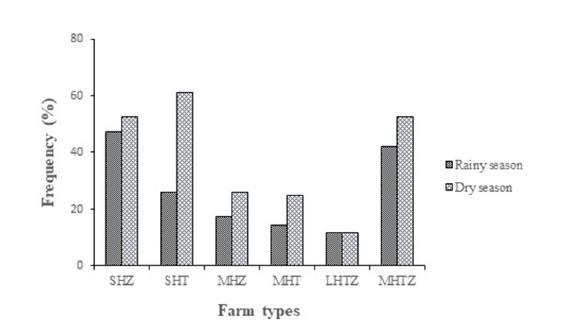
FIGURE5 Cattle watering on the farm across dairy cattle farm types in peri-urban areas of south Benin.